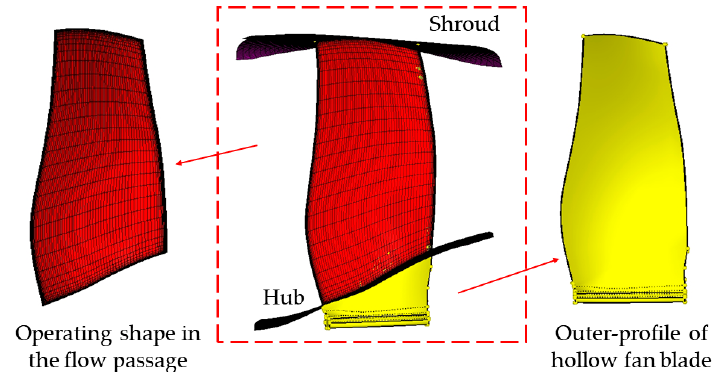
Table 2. Structural parameters of wide-chord fan blade. Figure 10. Model of wide-chord fan blade.